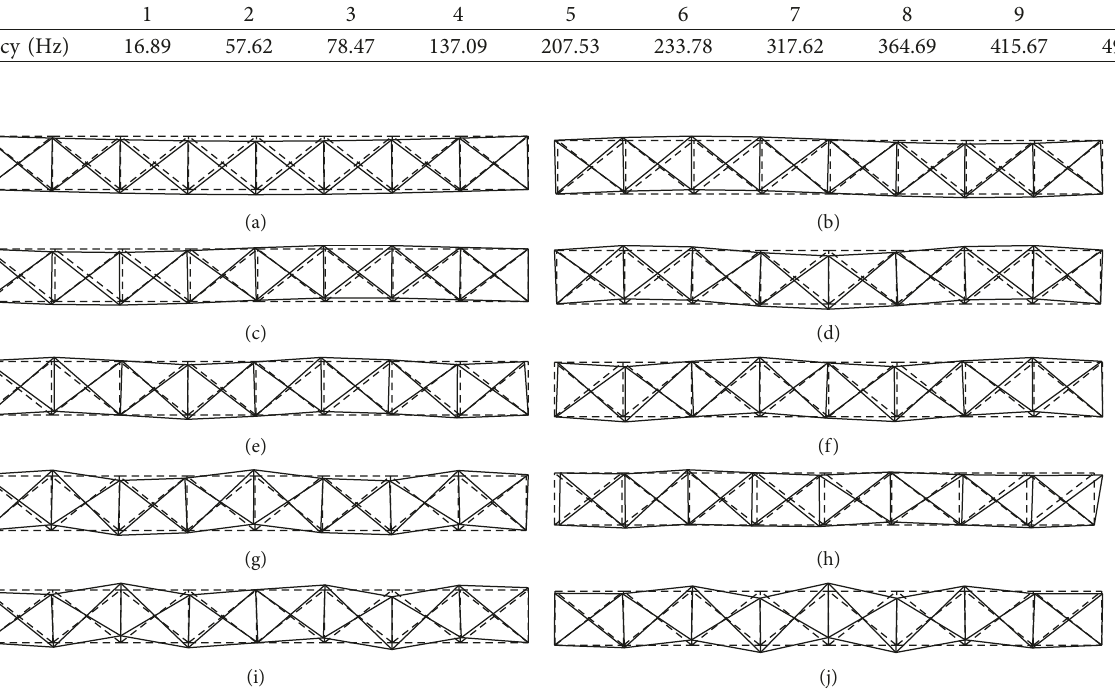
Figure 3: Mode shapes of the first ten modes of the planar truss (the thin dashed lines represent the equilibrium configuration, while the thick solid lines denote modal displacements enlarged by 2 times): (a) mode 1, (b) mode 2, (c) mode 3, (d) mode 4, (e) mode 5, (f) mode 6, (g) mode 7, (h) mode 8, (i) mode 9, and (j) mode